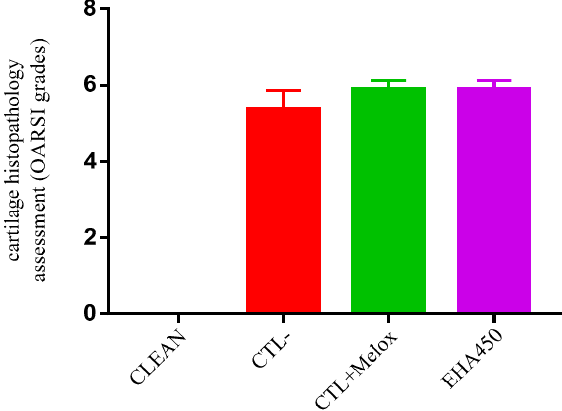
Figure 8. Histopathological evaluation of cartilage classified using the Osteoarthritis Research Society International (OARSI) scoring system. This analysis was performed with the knees collected on day 29 after OA induction. Groups: EHA450 = with sodium monoiodoacetate-induced osteoarthritis (MIA-induced OA) 2 mg and treated with A. chica hydroalcoholic extract 450 mg / kg; CTL − = with MIA-induced OA (2 mg) and treated with 0.9% sodium chloride saline; CTL + Melox = with MIA-induced OA (2 mg) and treated with meloxicam 0.5 mg / kg; CLEAN = untreated and uninduced OA, healthy. Y -axis: Histopathological evaluation of cartilage (OARSI histological classification: Grade 0—surface intact and cartilage intact; Grade 1—surface intact; Grade 2—surface discontinuity; Grade 3—vertical fissures; Grade 4—erosion; Grade 5—denudation; and Grade 6—deformation).